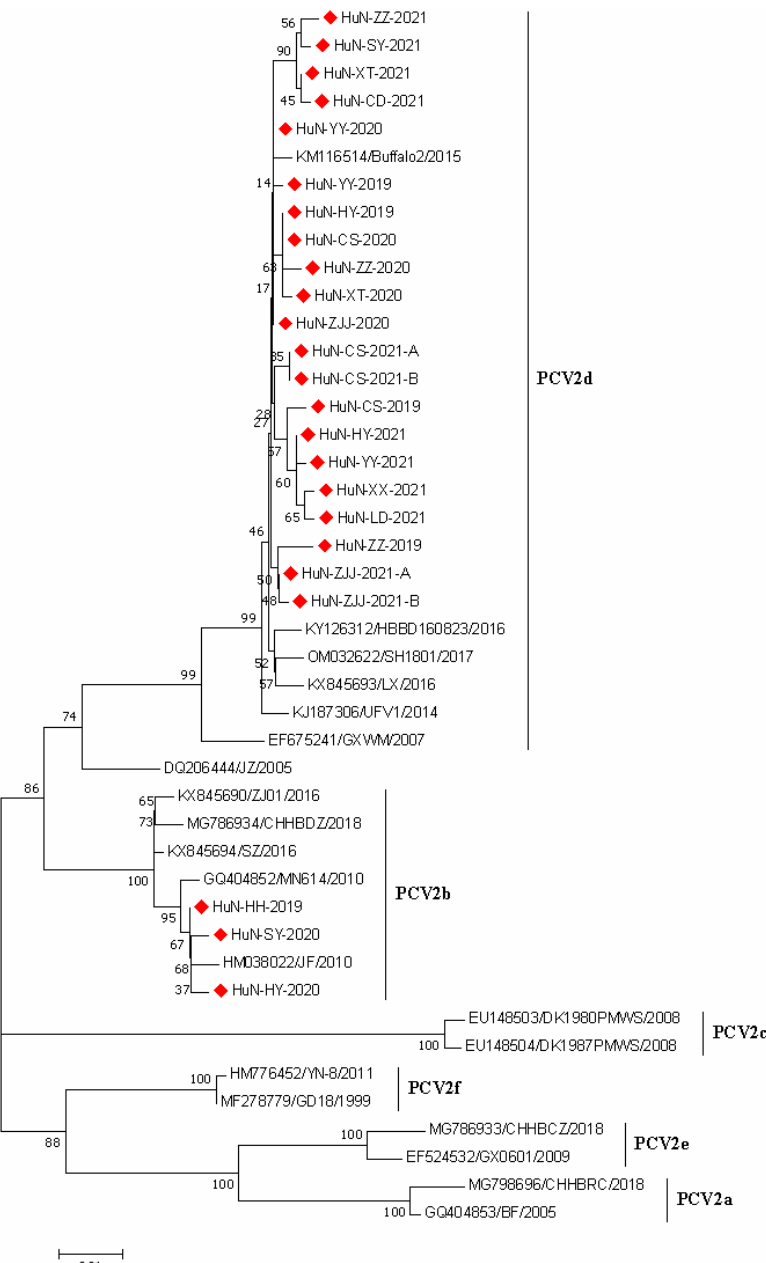
Figure 2. Phylogenetic tree based on ORF2 gene sequences of 24 PCV2 strains identified in this study and other reference strains generated by the neighbor-joining method in MEGA 7.0 software, with 1000 bootstrap support. The red prismatics represent these newly identified PCV2 strains.